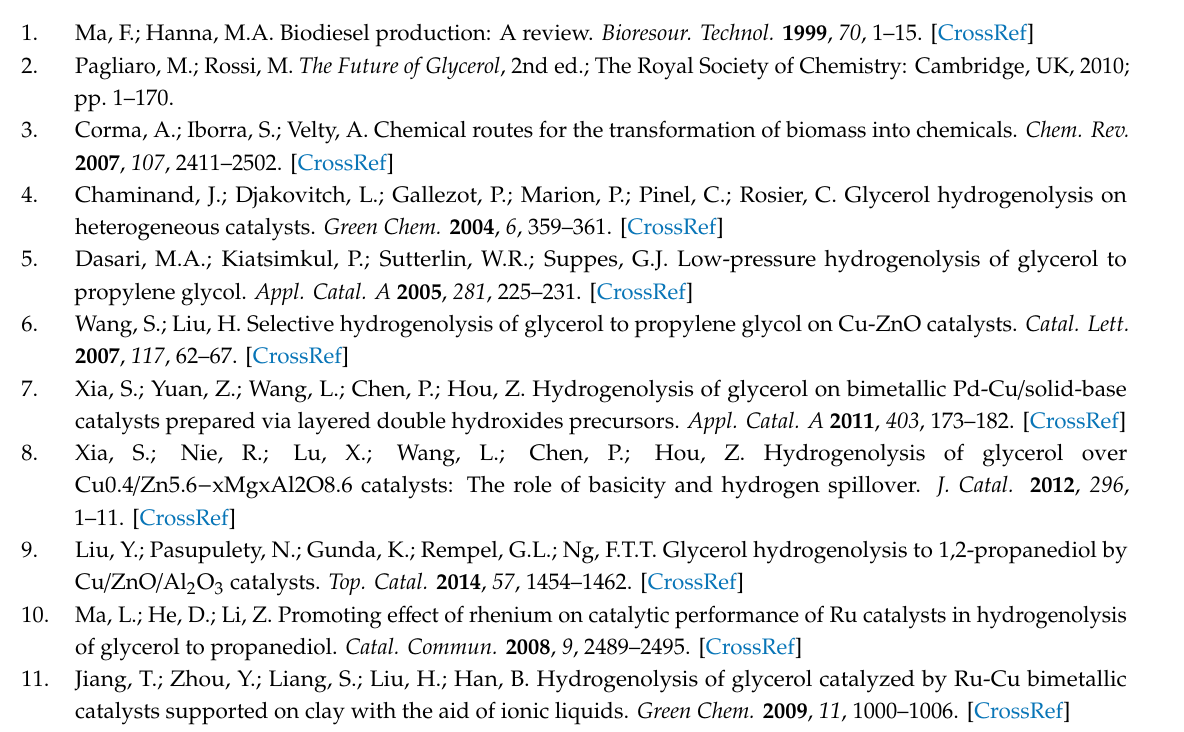
mass transfer limitations, Table S1: Space Time Yields for glycerol hydrogenolysis with in situ H 2 from methanol steam reforming over Cu / ZnO / Al 2 O 3 -Na catalyst, Tables S2–S4: Space Time Yields for glycerol hydrogenolysis with in situ H 2 from methanol steam reforming over Cu / ZnO / Al 2 O 3 -OA catalysts, Tables S5–S7: Space Time Yields for glycerol hydrogenolysis with in situ H 2 from methanol steam reforming over Ni / Cu / ZnO / Al 2 O 3 -OA catalysts, Table S8: Space Time Yields for acetol hydrogenation over Cu / ZnO / Al 2 O 3 -OA catalyst, Table S9: Space Time Yields for acetol hydrogenation over Ni / Cu / ZnO / Al 2 O 3 -OA